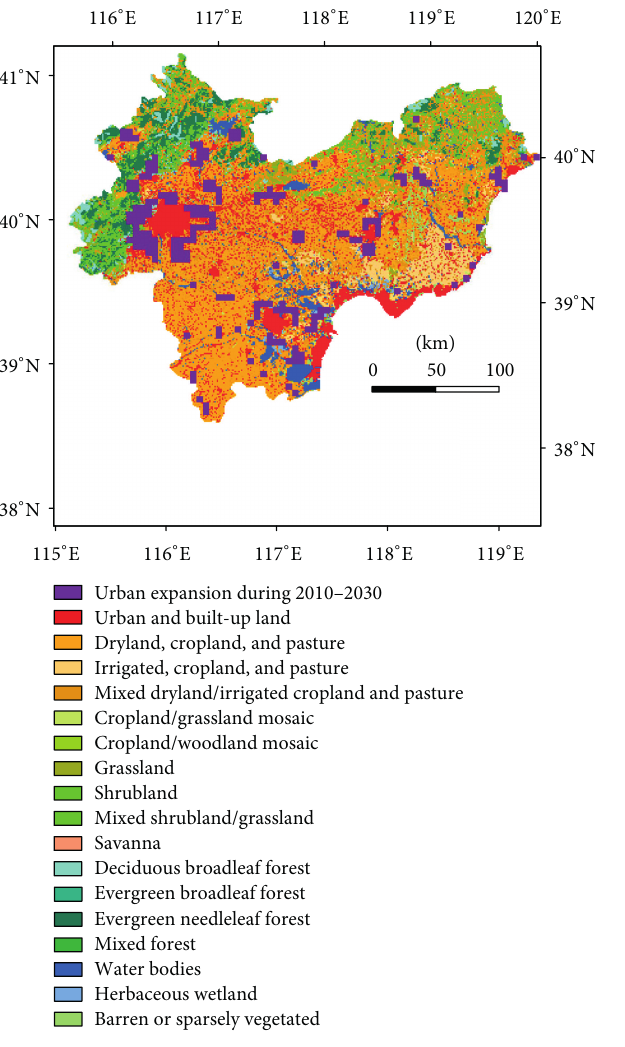
Figure 2: Conversion from other land use types to urban area in Beijing-Tianjin-Tangshan Metropolitan area during 2010 to 2030.